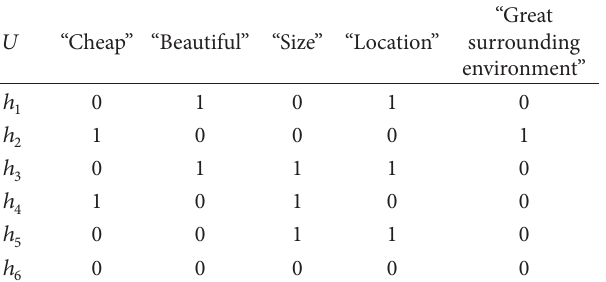
(̃𝐹, 𝐴) . “Great surrounding